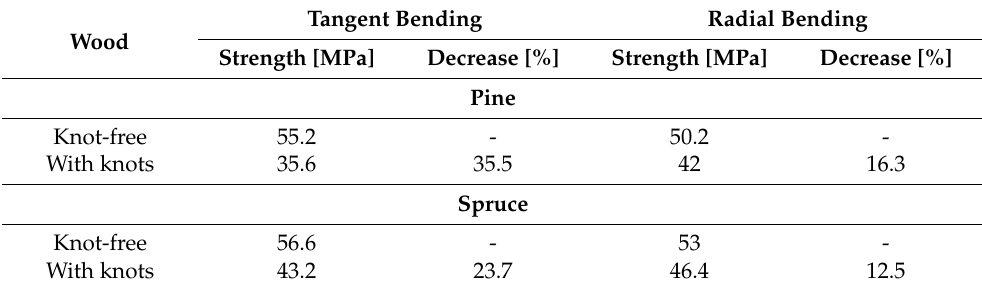
Table 5. Effect of knots on the tangential and radial bending strength of pine and spruce wood [63]. Tangent Bending Radial Bending Wood Strength [MPa] Decrease [%] Strength [MPa] Decrease [%] Pine Knot-free 55.2 - 50.2 - With knots 35.6 35.5 16.3 Spruce Knot-free 56.6 - - With